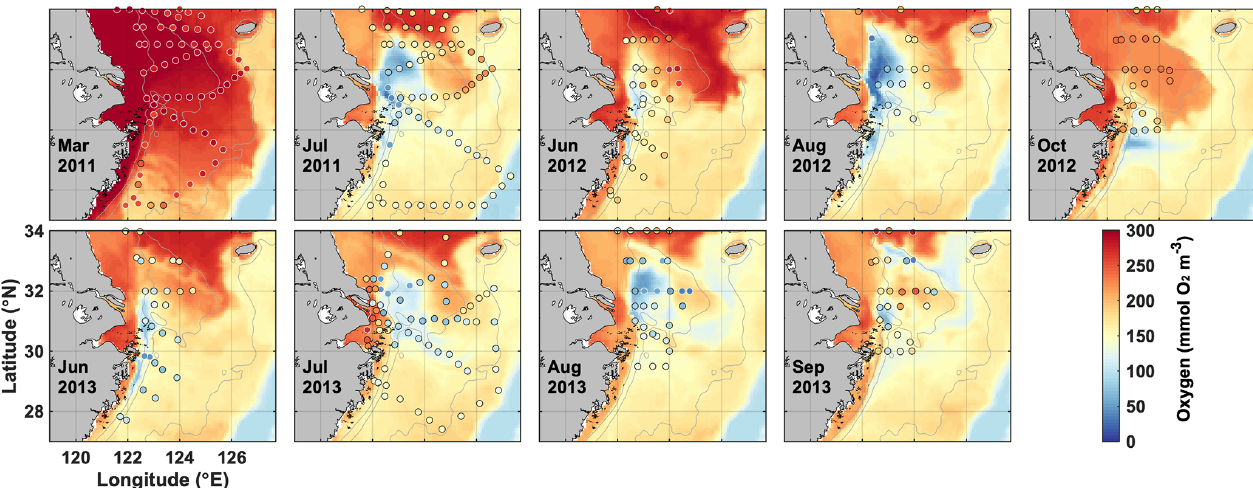
Figure 3. Simulated bottom oxygen (colored map) shown for the day that marks the mid-point of the cruise dates compared with observations (dots) during nine cruises from 2011 to